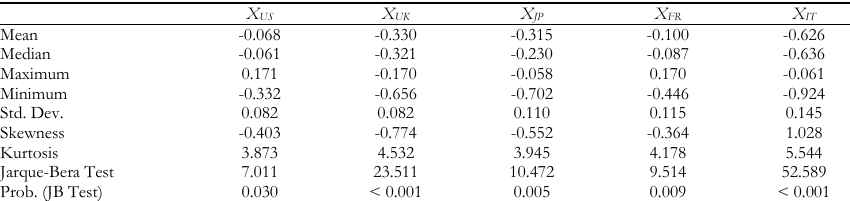
Descriptive statistics for variables X